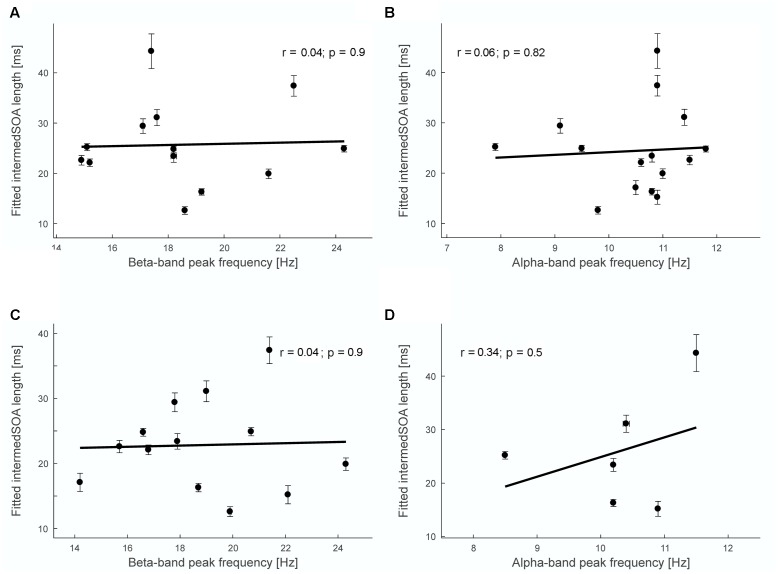
Correlation analysis between fitted intermedSOA lengths and peak frequencies.
(A) Non-significant Pearson’s correlation between fitted intermedSOA lengths and beta-band peak frequency determined for sensor-level individual M50 sensors (r = 0.04, p = 0.9). (B) Non-significant Pearson’s correlation between fitted intermedSOA lengths and alpha-band peak frequency determined for sensor-level individual M50 sensors (r = 0.06, p = 0.82). (C) Non-significant Pearson’s correlation between fitted intermedSOA lengths and beta-band peak frequency determined for source-level M50 grid point (r = 0.04, p = 0.9). (D) Non-significant Pearson’s correlation between fitted intermedSOA lengths and alpha-band peak frequency determined for source-level individual M50 grid point (r = 0.34, p = 0.5). Insets in (A–D) show results of the linear regression analyses (black lines). Vertical arrow bars indicate standard errors of the fitted intermedSOA, horizontal error bars indicate the interquartile range for the bootstrap estimation of peak frequencies.